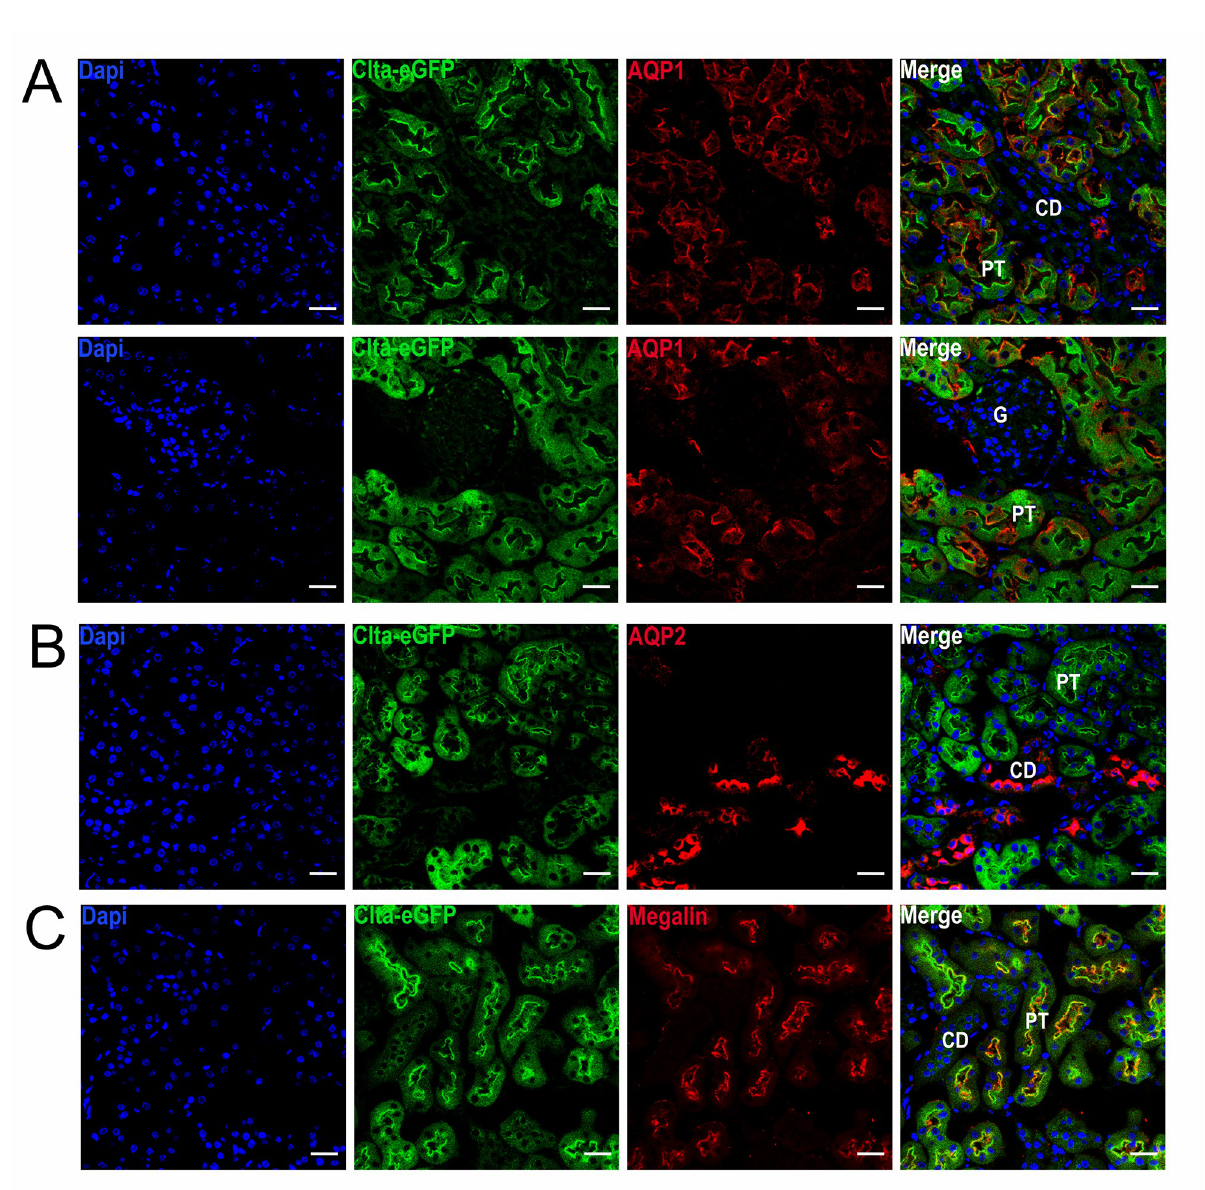
Fig 3. Localization of the Clta-eGFP signal in kidney sections. ( A ) Clta-eGFP reporter kidney section stained for aquaporin-1 (AQP1) showing that the Clta-eGFP signal is localized to proximal tubule. ( B ) Clta-eGFP reporter kidney sections stained for aquaporin-2 (AQP2) showing that the Clta- eGFP is not detectable in collecting duct of murine kidney. ( C ) Clta-eGFP reporter co-localizes partly with the brush border resident protein megalin. Scale bar: 25 μ m, CD: collecting duct, G: glomerulus, PT: proximal